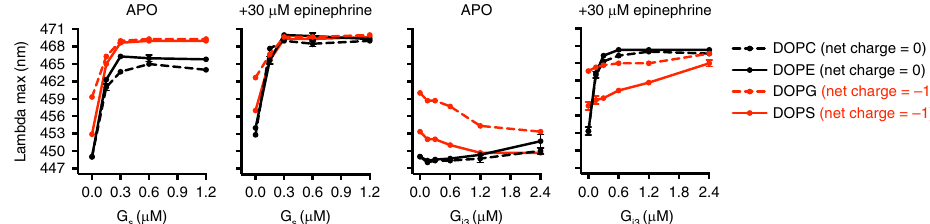
Fig. 4 Bilayer charge differentially affects G s and G i3 coupling. The effect of G s (left) and G i3 (right) concentration on mB − β 2 AR fl uorescence was examined in nanodisc bilayers of varying phospholipid composition (DOPC, DOPE, DOPG, DOPS). Epinephrine was omitted (APO) or included (30 μ M). Interaction with G protein is read out as an increase in lambda max. The net charge of the phospholipid is indicated in parentheses. mB − β 2 AR concentration is 100 nM; maximum stoichiometry is 12:1 (for G s ) and 24:1 (for G i3 ). Data are mean ± s.e.m. of three independent experiments. Source data are provided in